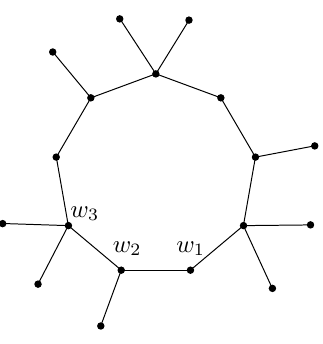
Fig. 5: The graph G = ( P 1 ( w 1 ) , P 2 ( w 2 ) , P 3 ( w 3 )) 3 , where P s is the path of order s and w 3 is the central vertex of P 3